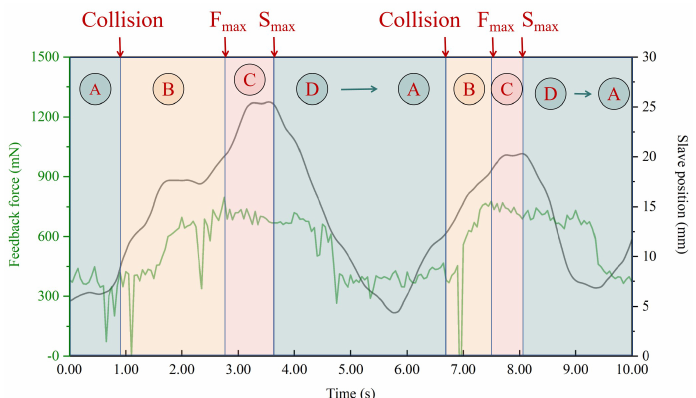
Figure 9. The Real time surgical state classification.